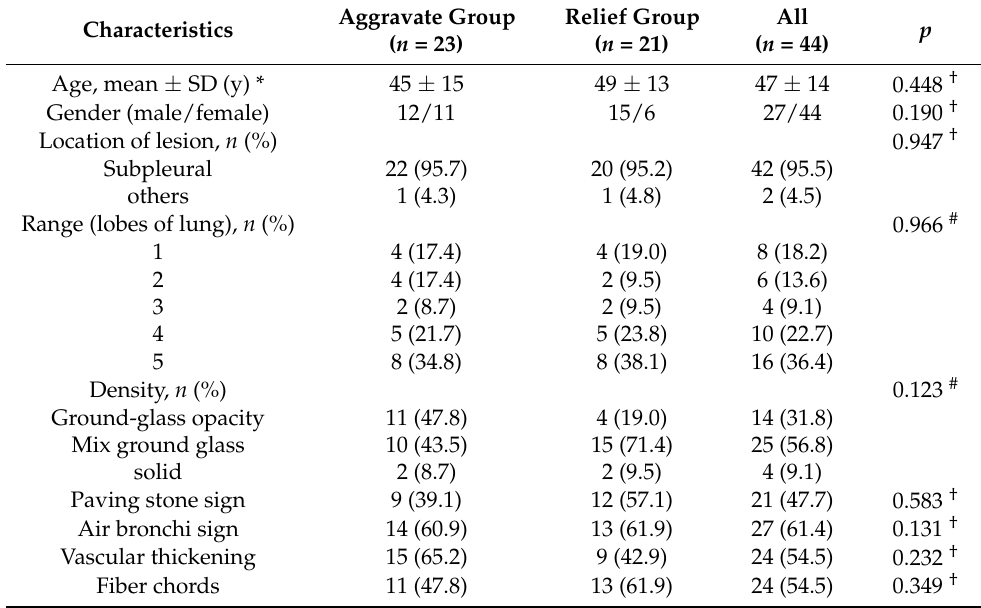
Table 1. Clinical characteristics of patients in aggravate and relief groups.